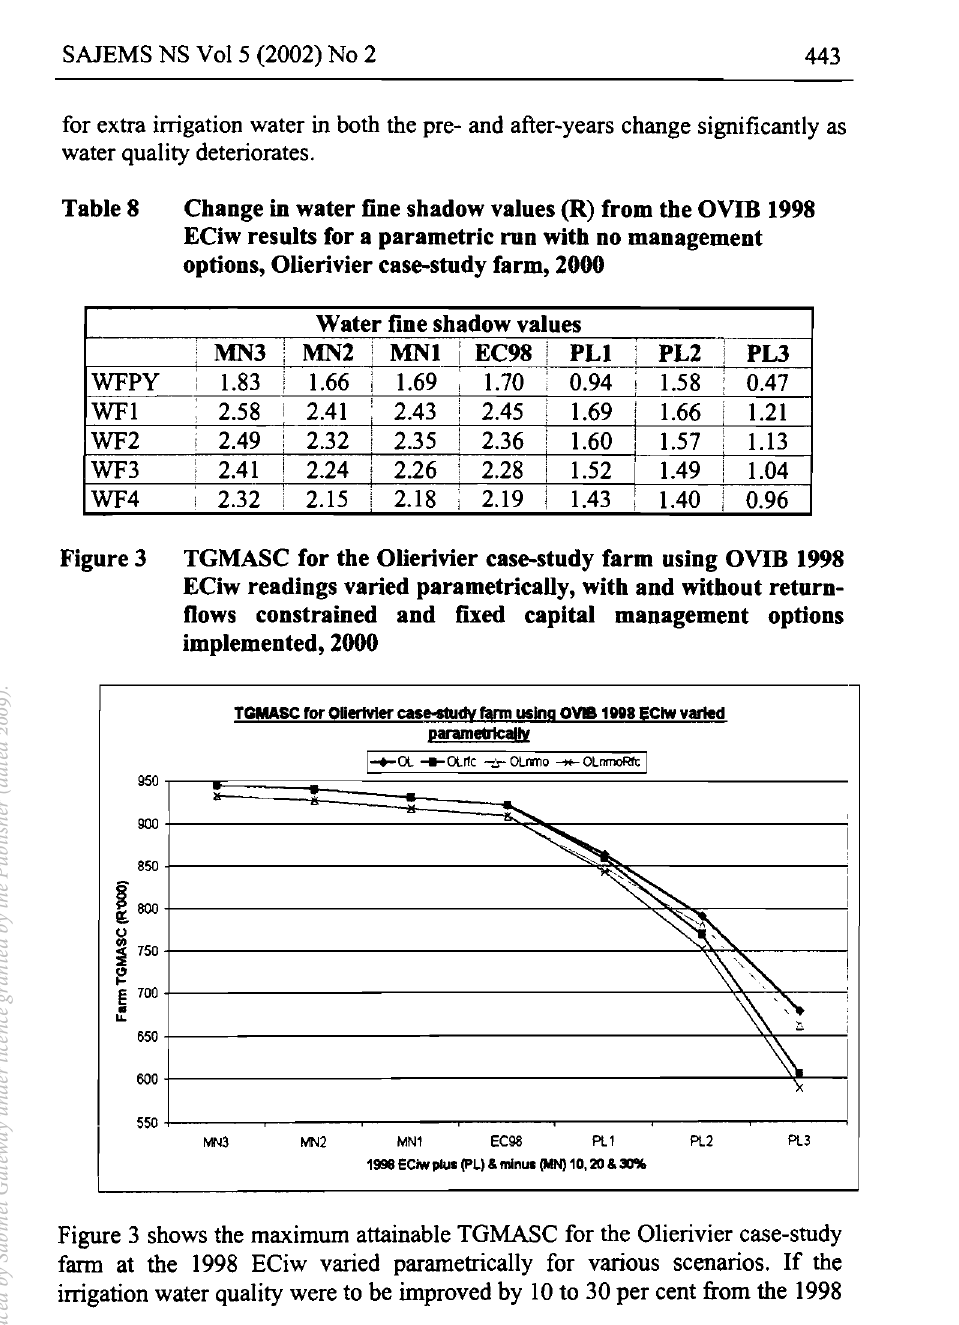
TGMASC for the Olierivier case-study farm using OVIB 1998 ECiw readings varied parametrically, with and without return flows constrained and fixed capital management options implemented,